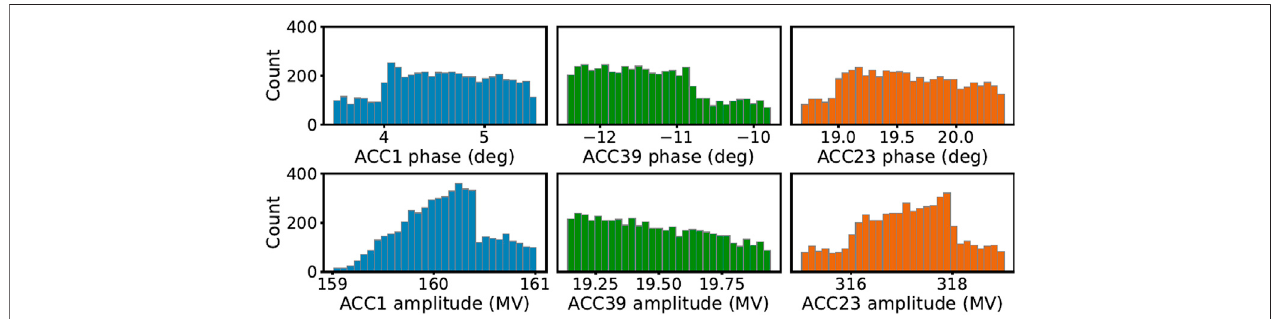
FIGURE7| HistogramsofthescannedparametersforadatasetofWP2.Thetotalnumberofdatapointsisabout5200.Theinputdataarenotuniformlydistributed because of two reasons. First, the data are combined from two datasets taken successively. The parameter ranges of the second dataset are smaller than the fi rst one. Second, more than 40% of the data are dropped, as discussed in Section 3.1 .